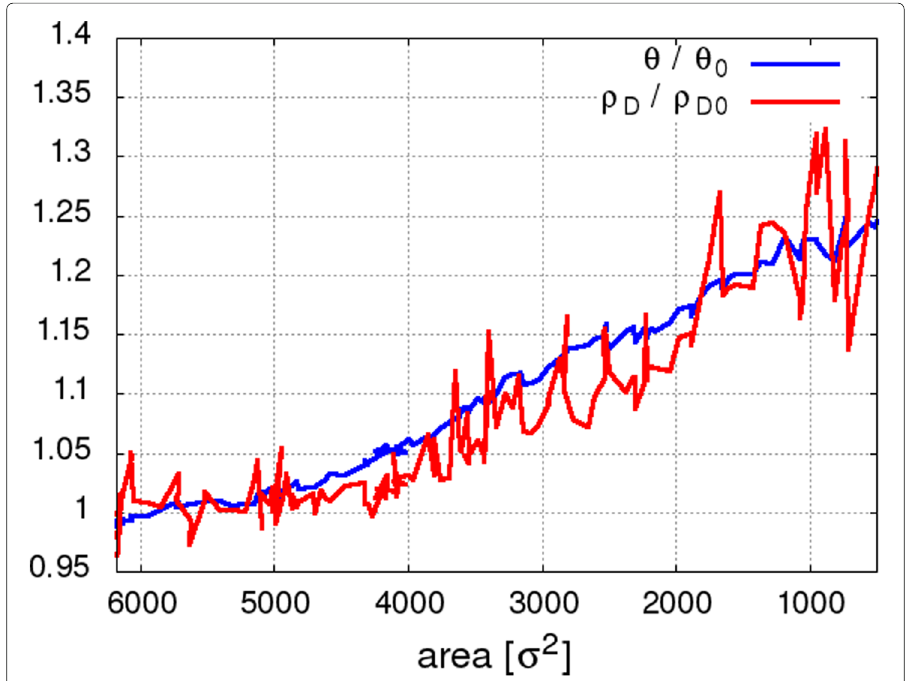
Fig. 4 Evaluation of the dislocation density ρ D /ρ D misorientation angle θ/θ 0 (blue curve) during grain shrinkage for θ 0 = 10